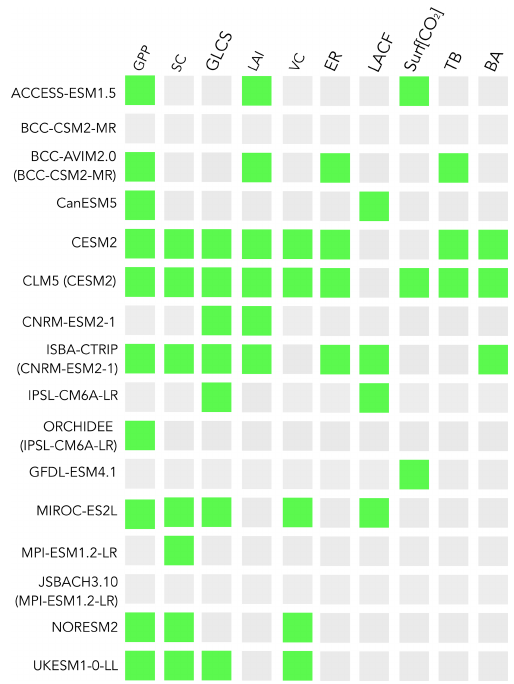
Figure 1. Validation (green) or omission (grey) of the 10 most frequently validated variables by participants (treating ESMs and LSMs separately): gross primary productivity (GPP), soil carbon (SC), global land carbon sink (GLCS), leaf area index (LAI), veg- etation carbon (VC), ecosystem respiration (ER), land–atmosphere CO 2 flux (LACF), surface CO 2 concentrations (Surf[CO 2 ]), total biomass (TB), and burned area (BA).